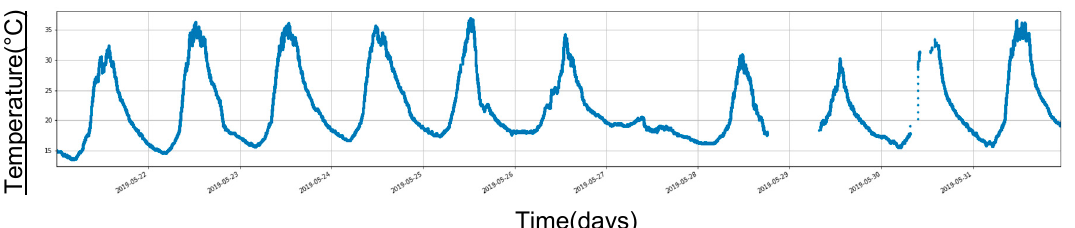
Figure 9. Filled values of temperature-2 during May 2019 (post fitting).